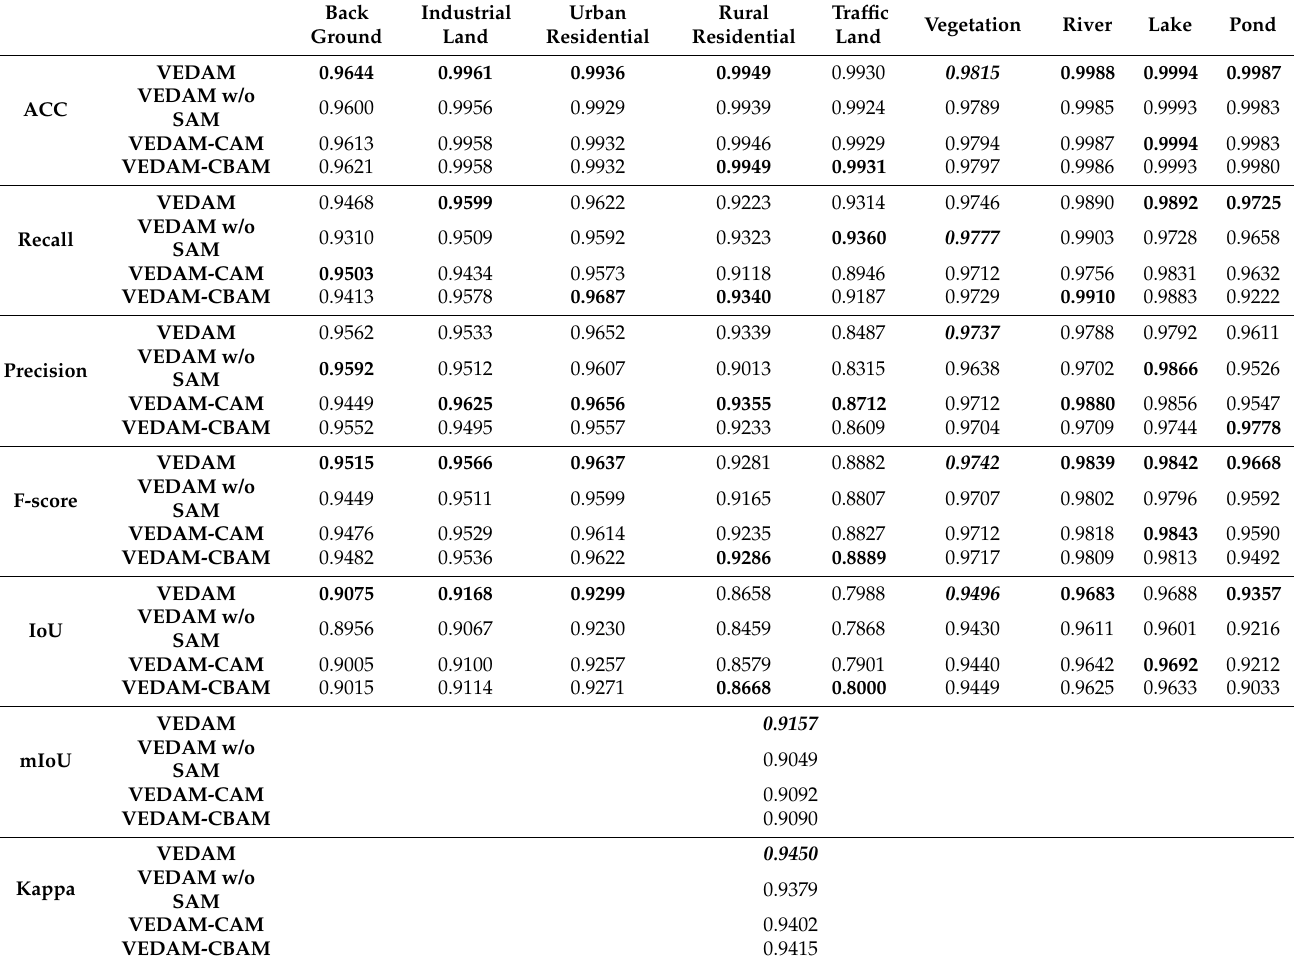
Table 6. Comparison results of VEDAM combined with different attention modules on the GID